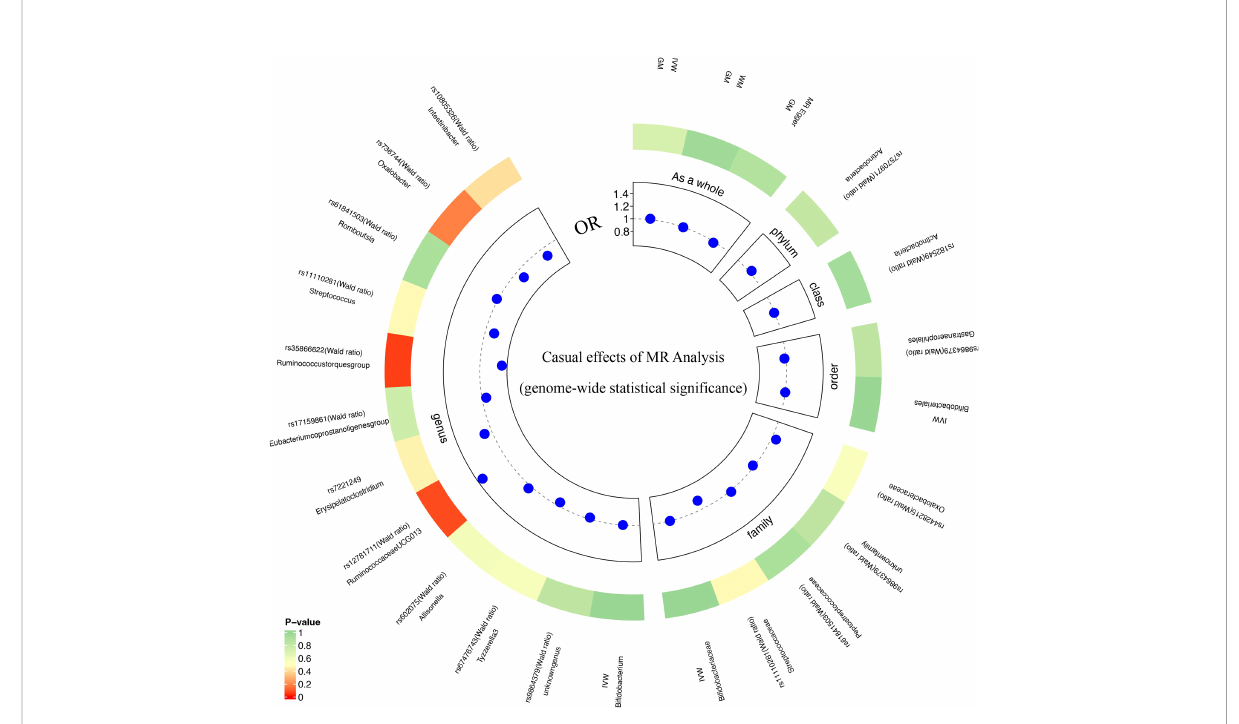
FIGURE 3 MR analysis results of GM and DR (genome-wide statistical signi fi cance, P <5×10 -8